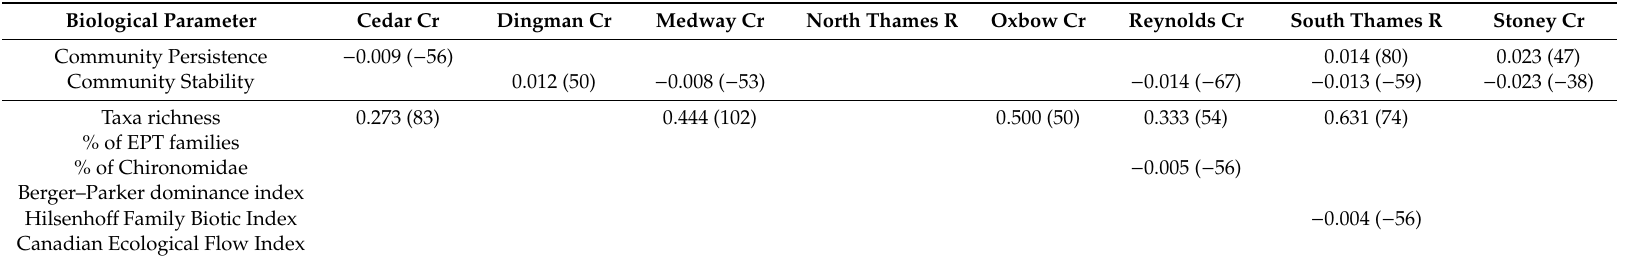
Table 4. Significant trends detected by regional Mann–Kendall tests for community persistence and stability, as well as six bioassessment metrics measured in eight di ff erent streams in the Upper Thames River Basin (southern Ontario, Canada). RKT-slope derived from the significant ( p -value < 0.01) Mann–Kendall tests. K-score in